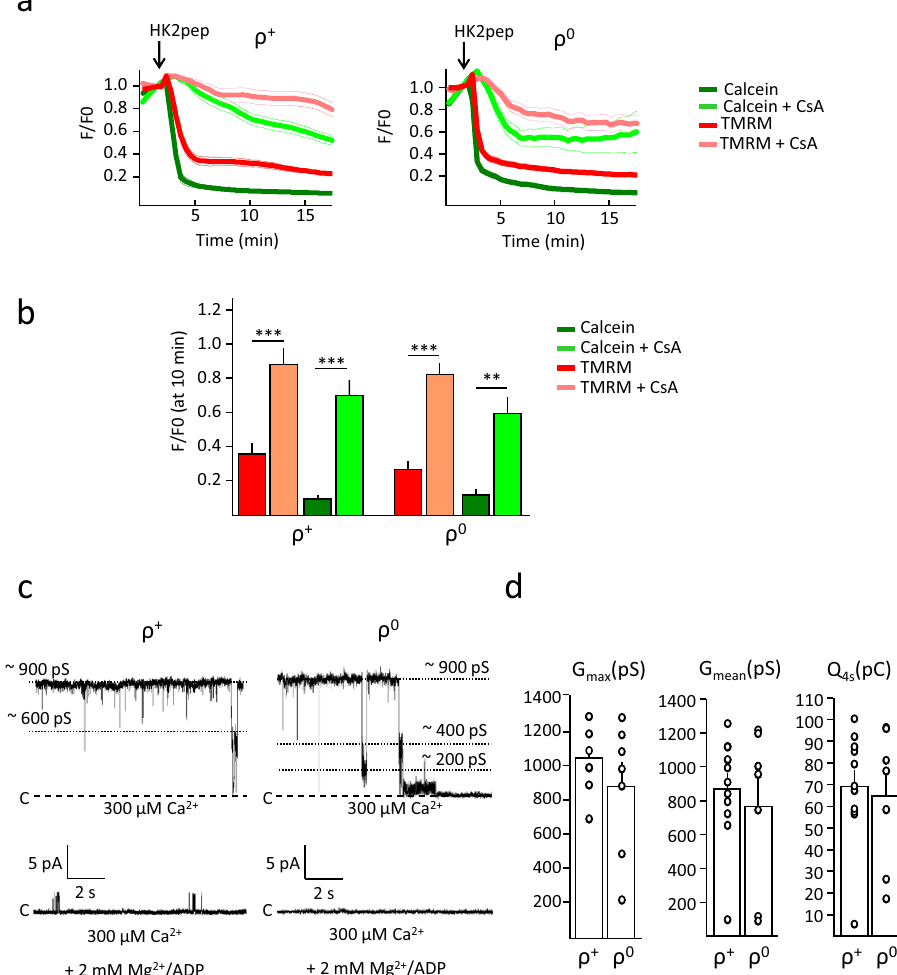
Fig. 5 The permeability transition pore in ρ + and ρ 0 cells. a Changes in mitochondrial calcein (green traces) and TMRM (red traces) fl uorescence intensities in the absence (dark colors) or presence (light colors) of 4 µ M CsA. Where indicated, 2.5 µ M HK2 peptide (pep) was added. Data are averages of the following ROIs over three independent experiments for each condition and genotype: for ρ + , 23 (HK2) and 43 (HK2 + CsA); for ρ 0 , 54 (HK2) and 59 (HK2 + CsA); SEM for each time point is denoted by thin lines. b Analysis of the calcein and TMRM fl uorescence intensities 8 min after peptide addition in the absence (dark colors) or presence (light colors) of 4 µ M CsA. Data are average ± SEM of the ROIs indicated above, *** p < 0.001, ** p < 0.01, two-sided Student ’ s t -test. c Representative current traces showing PTP channel activity obtained by patch-clamping isolated mitoplast from ρ + and ρ 0 cells in the presence of 300 µ M Ca 2 + ( V h = + 20 mV). Where indicated, 2 mM Mg 2 + /ADP was present. Currents were recorded in 11 experiments out of 17 in ρ + cells and in 10 experiments out of 12 in ρ 0 cells. d Histograms represent the maximal ( G max ) and mean conductance ( G mean ) and the net charge fl owing through a stable open channel in an interval of 4 s (Q 4s ) for the currents recorded in ρ 0 and ρ + mitoplasts. Only current traces with events out of the noise range were included in the analysis of G mean . Data are average ±